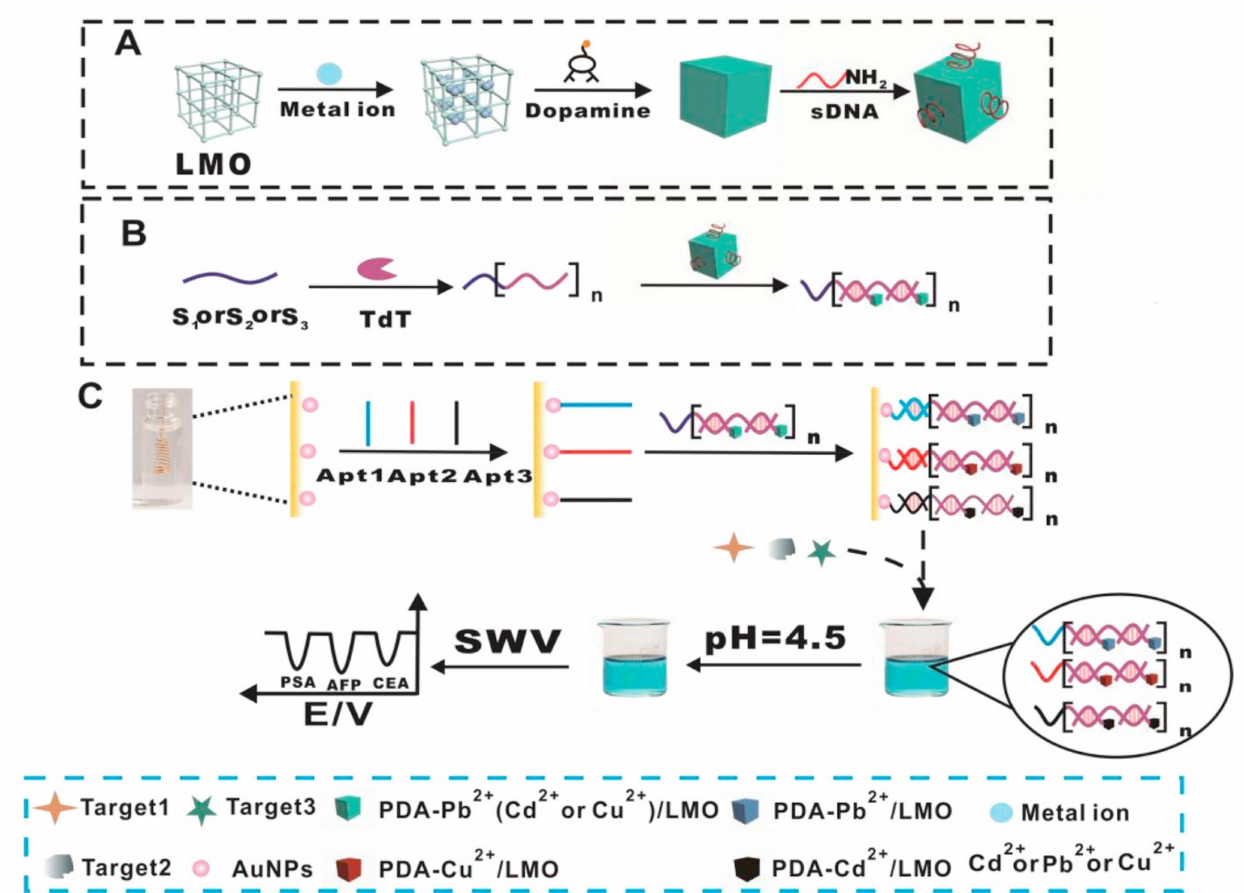
Figure 1. ( A ) The procedure of an encoded labels fabrication, ( B ) scheme of the DNA-(LMO-M) encoded probes formation, and ( C ) the multiplex detection scheme of serum tumor markers (reprinted with permission from Wang et al. 2021)